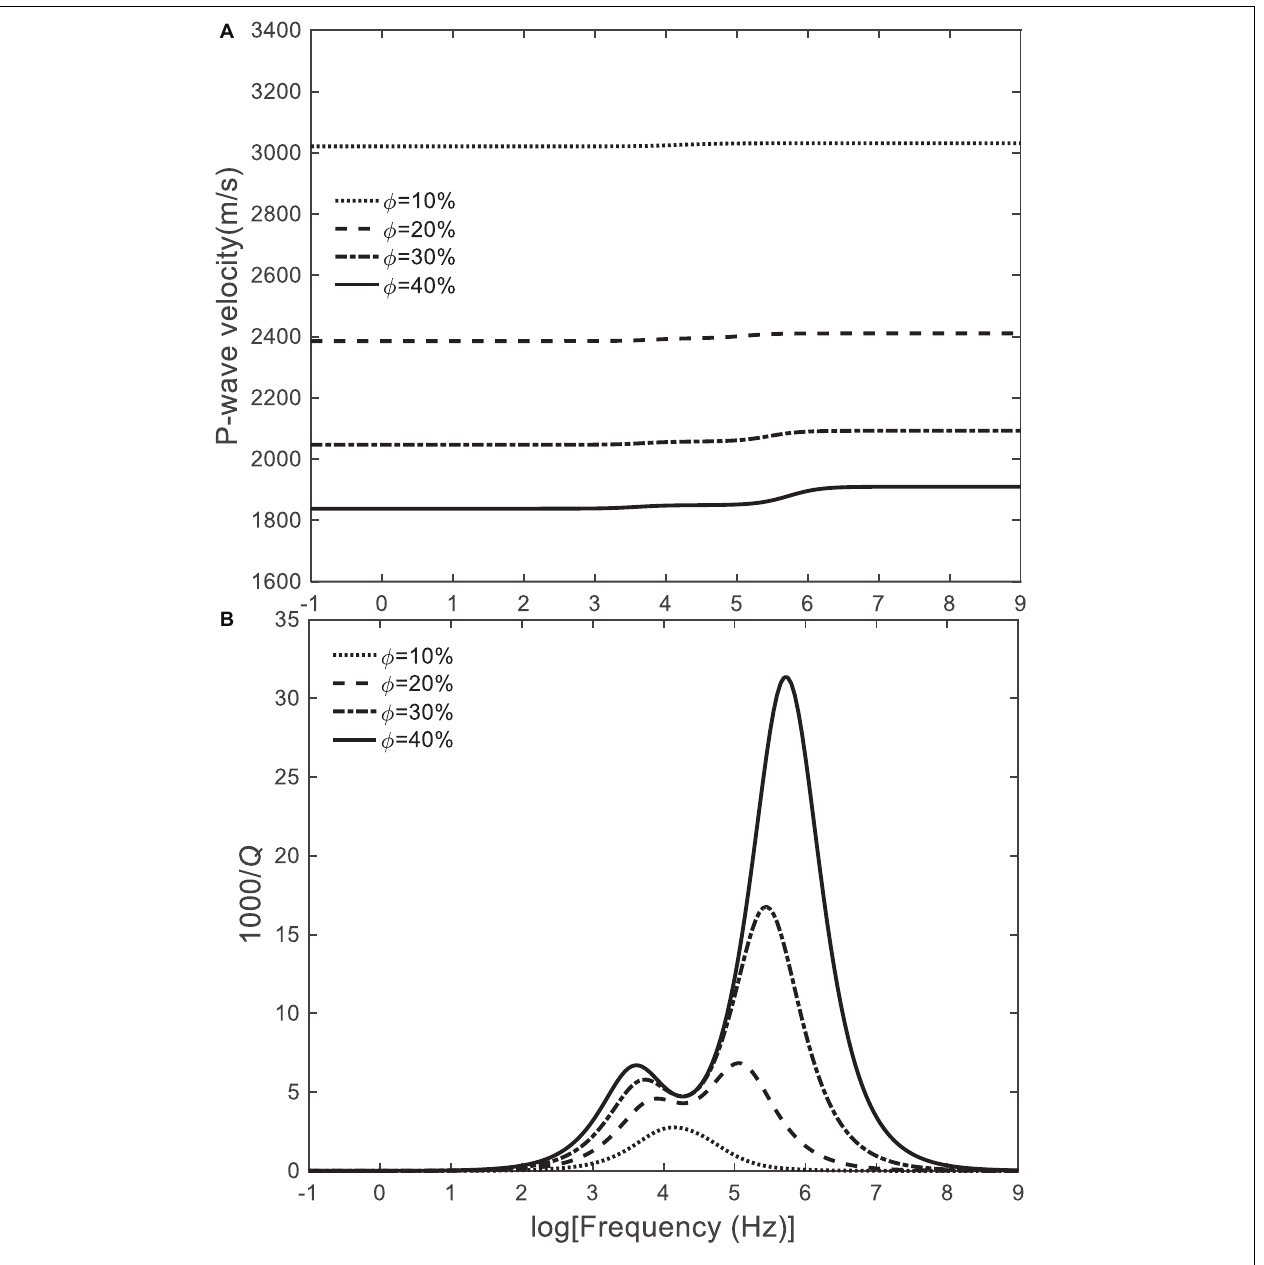
FIGURE 6 | Model 1. P-wave velocity (A) and dissipation factor (B) as a function of frequency for different rock porosities. The inclusion radius is 1 cm, and hydrate concentration is